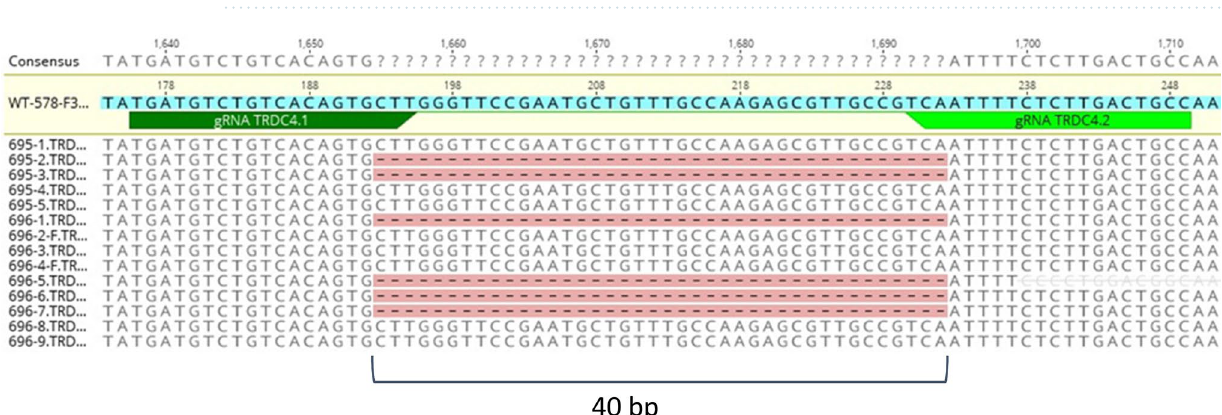
Figure 1. PCR-analysis of the porcine TRDC locus in samples from pigs generated by intracytoplasmic microinjection. Pigs 695-2, -3 and 696-1, -5, -6, -7 display a lower band of about 460 bp in contrast to wild type pigs (500 bp) indicating a 40 bp deletion caused application of the CRISPR/Cas9 construct (asterisk indicates modified pigs).